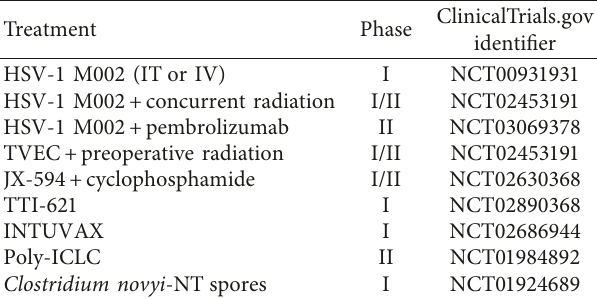
Table 2: Currently recruiting clinical trials of intratumoral im- munotherapy in soft tissue